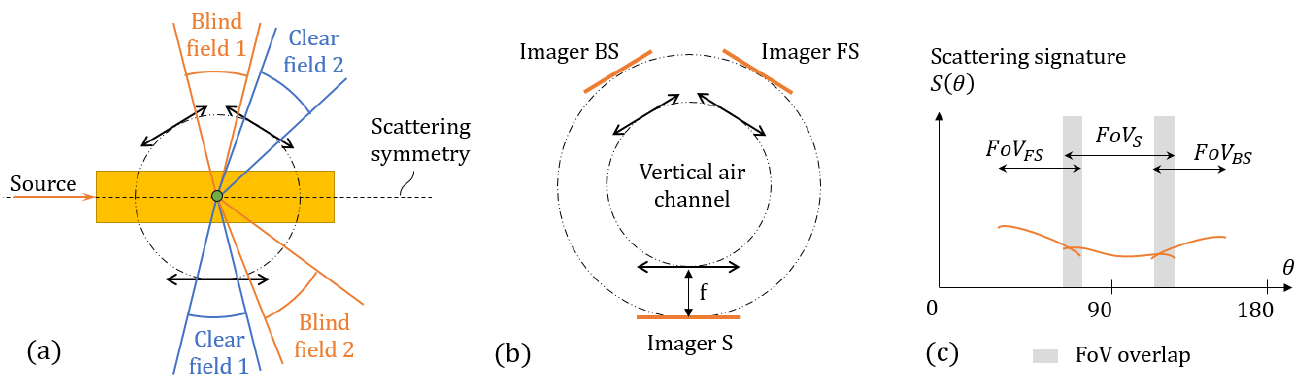
Figure 4. ( a ) Principle of blind fields asymmetrically coupled to clear fields. ( b ) Lenses coupled with imagers in Fourier planes. ( c ) Principle of overlapping sub ‐ FoV for signature reconstruction.